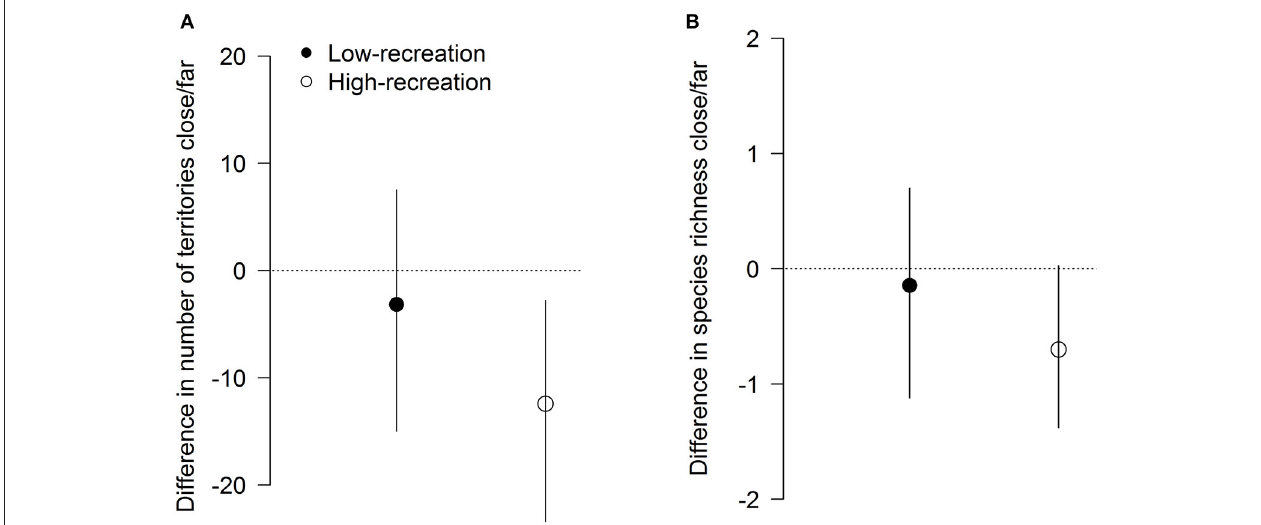
FIGURE 2 | Differences (mean ± 95% CrI) in the fitted number of territories (A) and species (B) between paired point-counts close to and far from trails in forests with low or high levels of recreation. Negative values indicate more territories or species far from trails. The dotted line (zero) represents an equal number of territories or species at both distances from the trail. Credible intervals that do not overlap the zero line represent a difference that is “significant” in a Bayesian analog to a significance test.